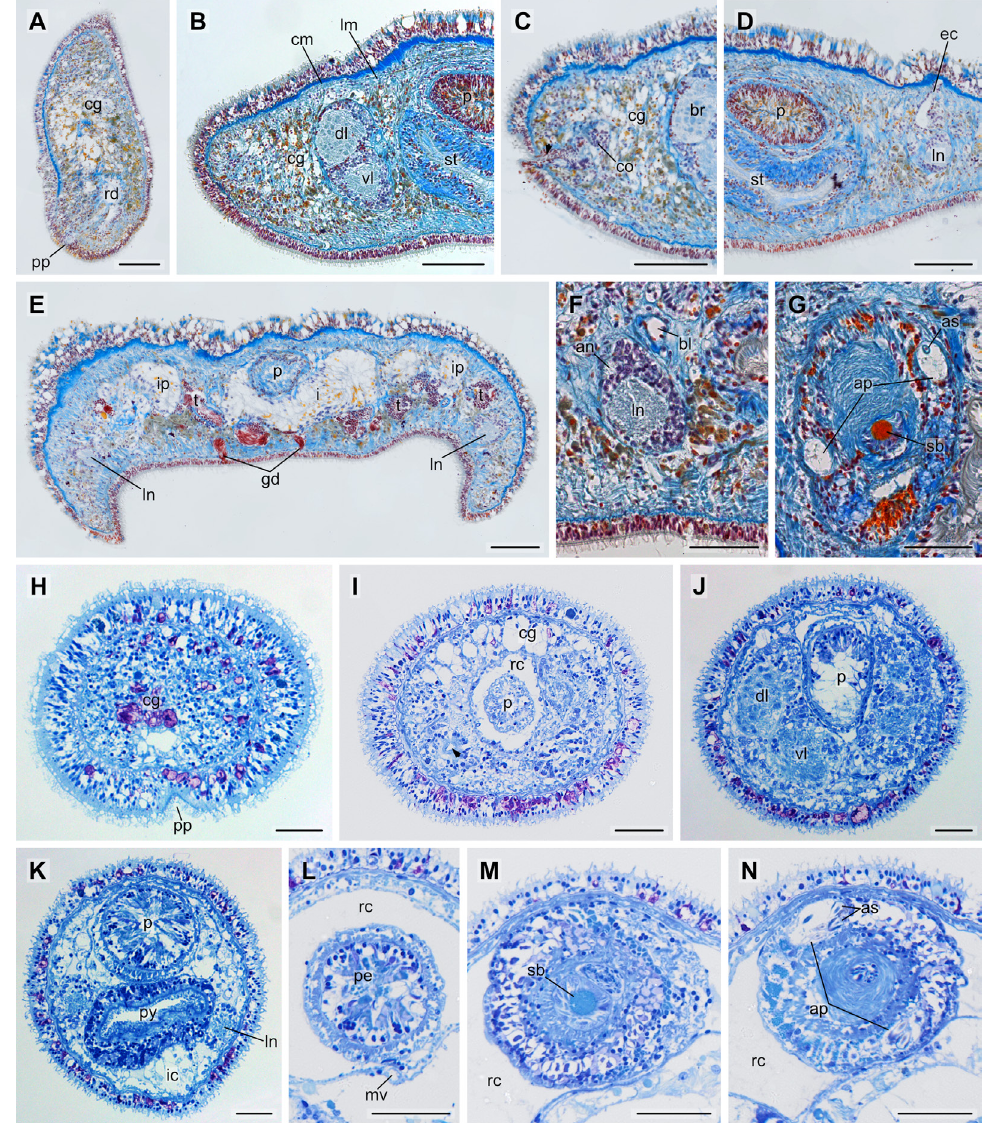
Fig. 10. A–G . Alvinonemertes dariae gen. et sp. nov., holotype (SIO-BIC N281), transverse histological sections. H–N . Alvinonemertes claudiae gen. et sp. nov., holotype (SIO-BIC N283), transverse histological sections. A . Anterior tip of head with proboscis pore. B . Brain region. C . Anterior brain region with cerebral canal (arrowhead). D . Stomach region with excretory canal. E . Posterior body region with testes. F . Lateral nerve cord with accessory nerve in stomach region. G . Proboscis armature, accessory stylet pouches with accessory stylets. H . Anterior tip of head with proboscis pore. I . Region anterior to cerebral ganglia with well-visible cerebral canal (arrowhead). J . Anterior brain region. K . Pyloric region. L . Proboscis and mid-dorsal vessel in stomach region. M . Proboscis armature, circular basis of central stylet. N . Proboscis armature, accessory stylet pouches with accessory stylets. Abbreviations: an = accessory nerve; ap = accessory stylet pouch; as = accessory stylet; bl = blood vessel; br = brain; cg = cephalic glands; cm = circular muscle layer; co = cerebral organ; dl = dorsal brain lobe; ec = excretory canal; gd = gonoduct; i = intestine; ic = intestinal cecum; ip = intestinal pouches; lm = longitudinal muscle layer; ln = lateral nerve cord; mv = mid-dorsal vessel; p = proboscis; pe = proboscis epithelium; pp = proboscis pore; py = pylorus; rc = rhynchocoel; rd = rhynchodaeum; sb = stylet basis; st = stomach; t = testis; vl = ventral brain lobe. Scale bars: A–G = 100 µm; H–N = 30